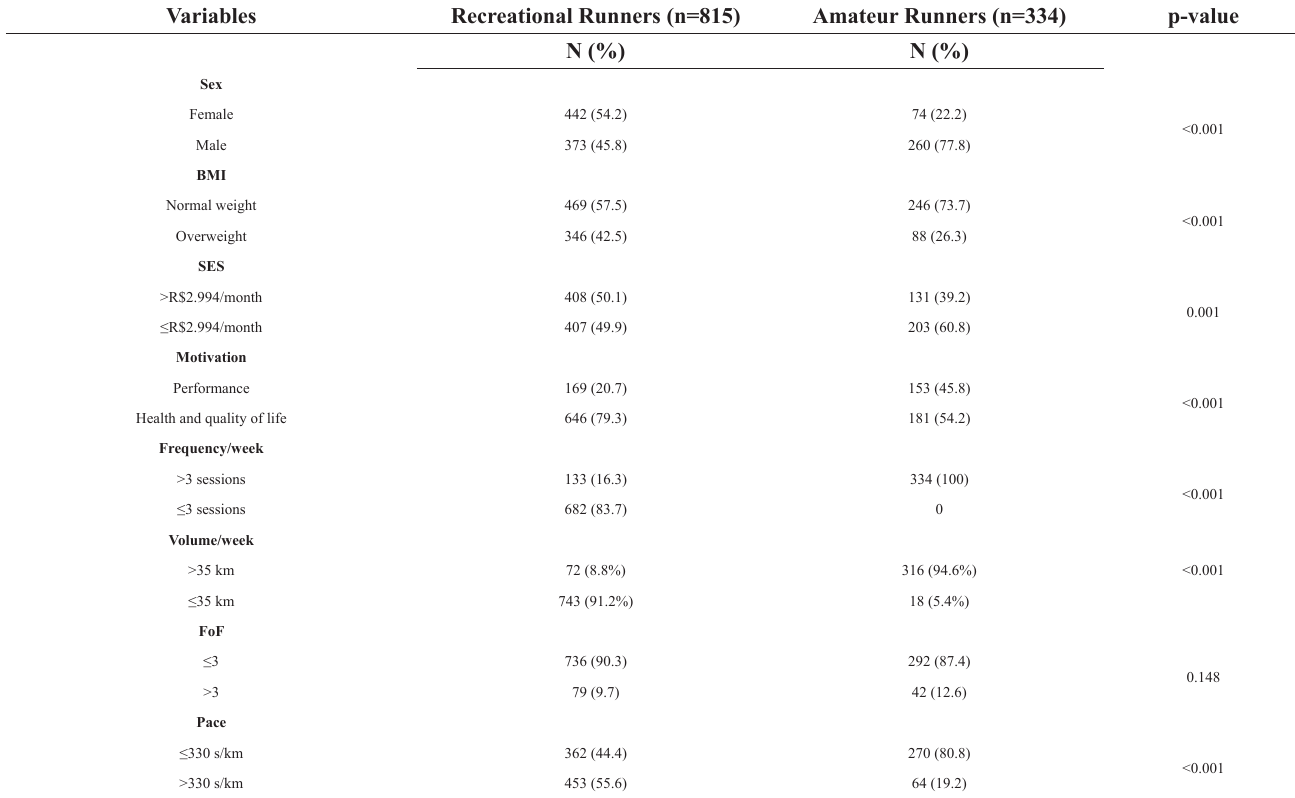
Table 3 - Frequencies of characteristics between latent classes